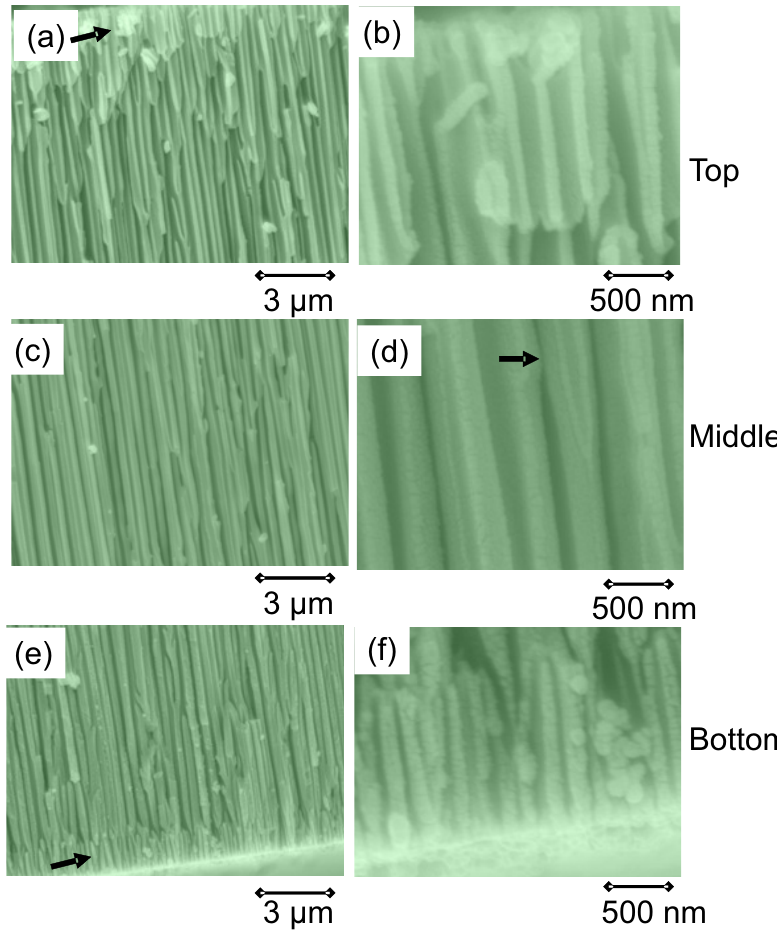
Figure 7. SEM analysis of the cross section of a commercial AAO template with 100 nm nominal pore diameter. The magnification of images ( a , c , e ) is 10,000 × , and images ( b , d , f ) have a magification of 50,000 × . A top layer and a bottom layer (arrows in panels ( a , e )), which is about 1–1.5 µ m thick, showing an irregular arrangement of the pores, can be clearly seen. The arrow in panel ( d ) points to a constriction, which is typically found in the middle section of the templates, defining the nominal pore